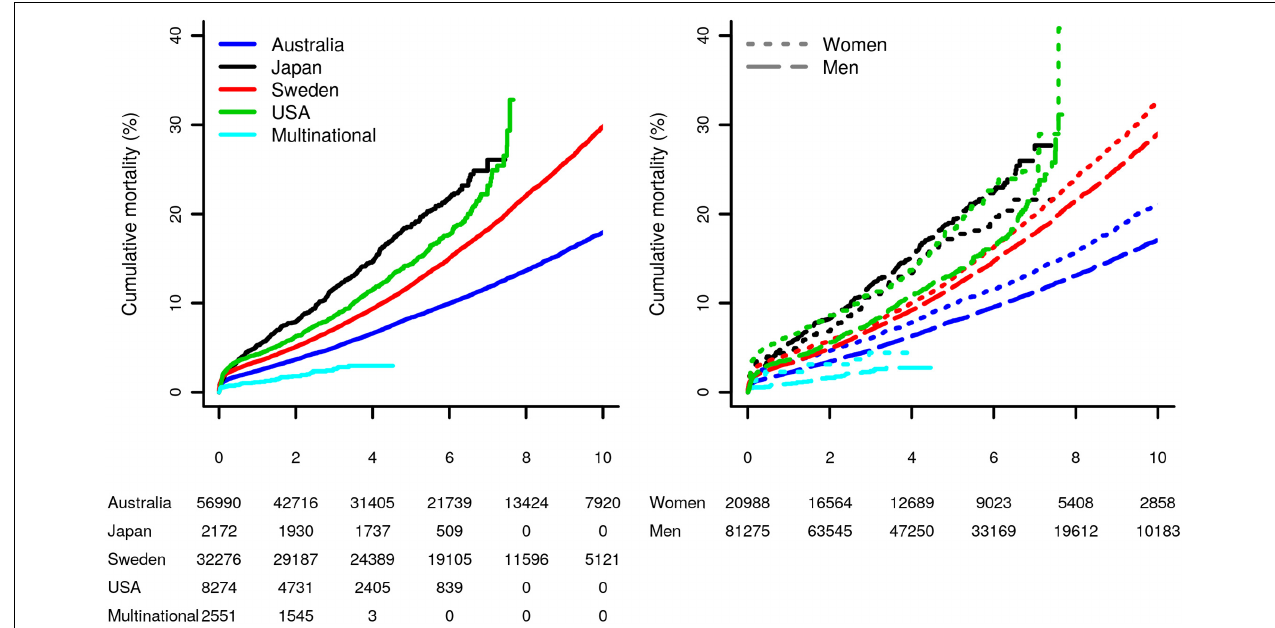
FIGURE 2 | Study-specific Kaplan–Meier curves of the post-CABG cumulative mortality, for the overall sample, as well as stratified by sex. Results were stratified by study as well as by sex (difference between survival curves in the left and right plots were significant, with the both p -values < 2 × 10 − 16 ). Subjects at risk are shown in the bottom